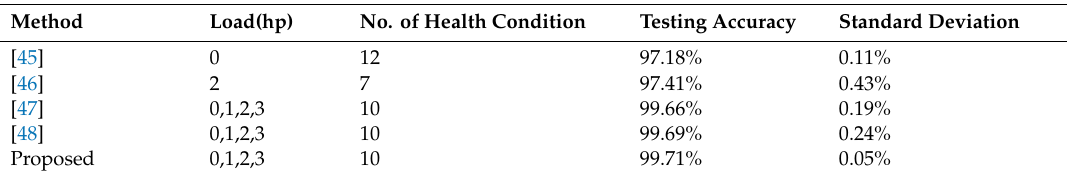
Table 3. Performance comparison with various studies.